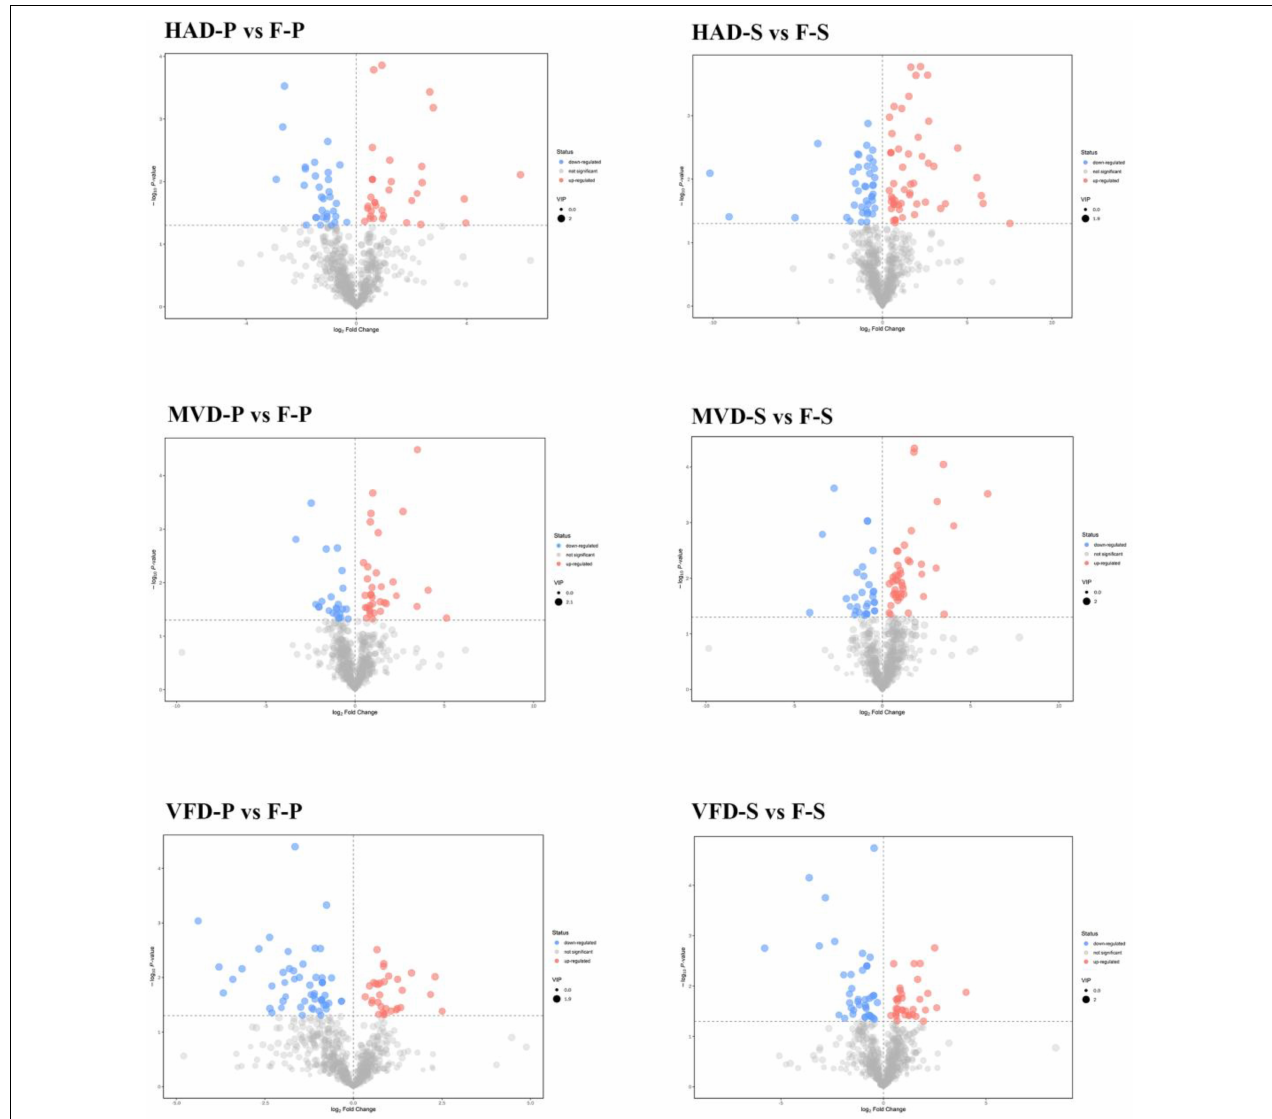
FIGURE 4 | Volcano plots of differential metabolites in different comparison